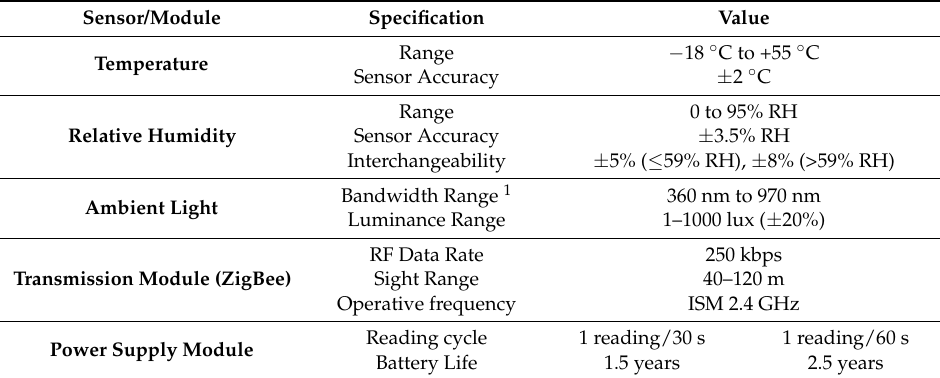
Table 1. L/H/T Sensors and dedicated modules performance.